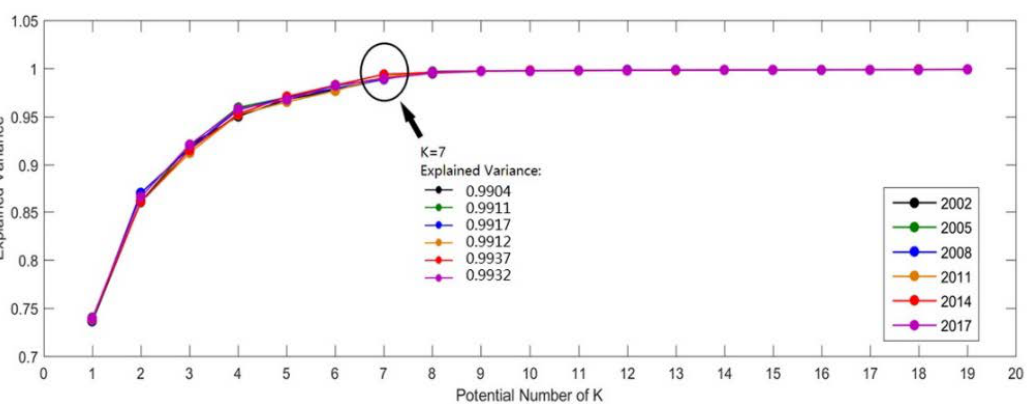
for spatial clustering. 𝑘𝑘